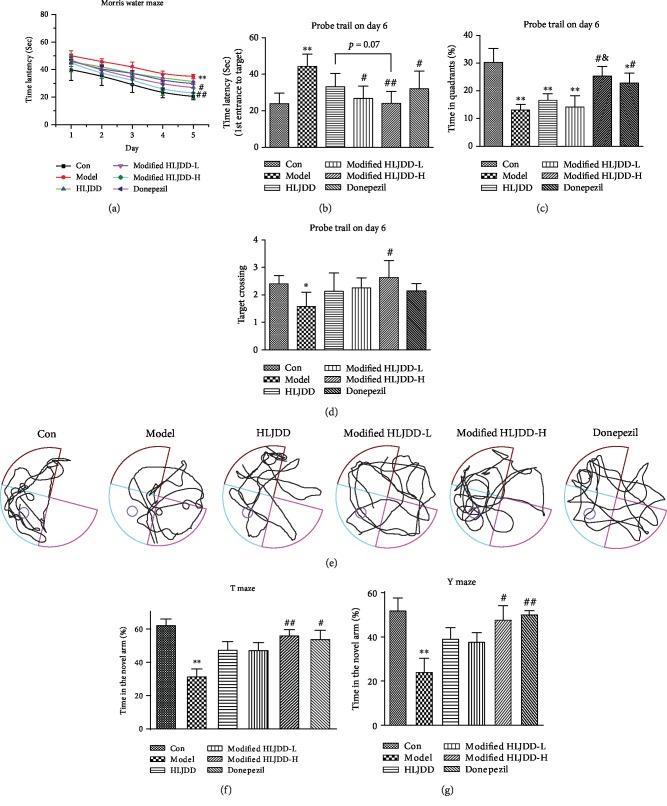
Modified-HLJDD attenuates learning and memory impairment in the Aβ1-42 oligomer-induced AD mouse model. (a–e) MWM tests were conducted after treatment with HLJDD, modified-HLJDD-L, modified-HLJDD-H, or donepezil. (a) The escape latency during a five-day training course. (b) In the probe tests, mice were analyzed for the escape latency; (c) the time spent in the target zone; (d) target crossing. (e) Representative path tracings in each quadrant during the probe trial. (f, g) T-maze/Y-maze results after HLJDD, modified-HLJDD-L, modified-HLJDD-H, or donepezil treatment in the AD model are presented as time spent in the novel arm. n = 12 per group. Results are expressed as the mean ± SEM. ∗∗p < 0.01, ∗p < 0.05 vs. control group; ##p < 0.01, #p < 0.05 vs. model group; and &p < 0.05 vs. HLJDD group. Statistical significance was determined by one-way ANOVA and Bonferroni tests as post hoc comparisons.